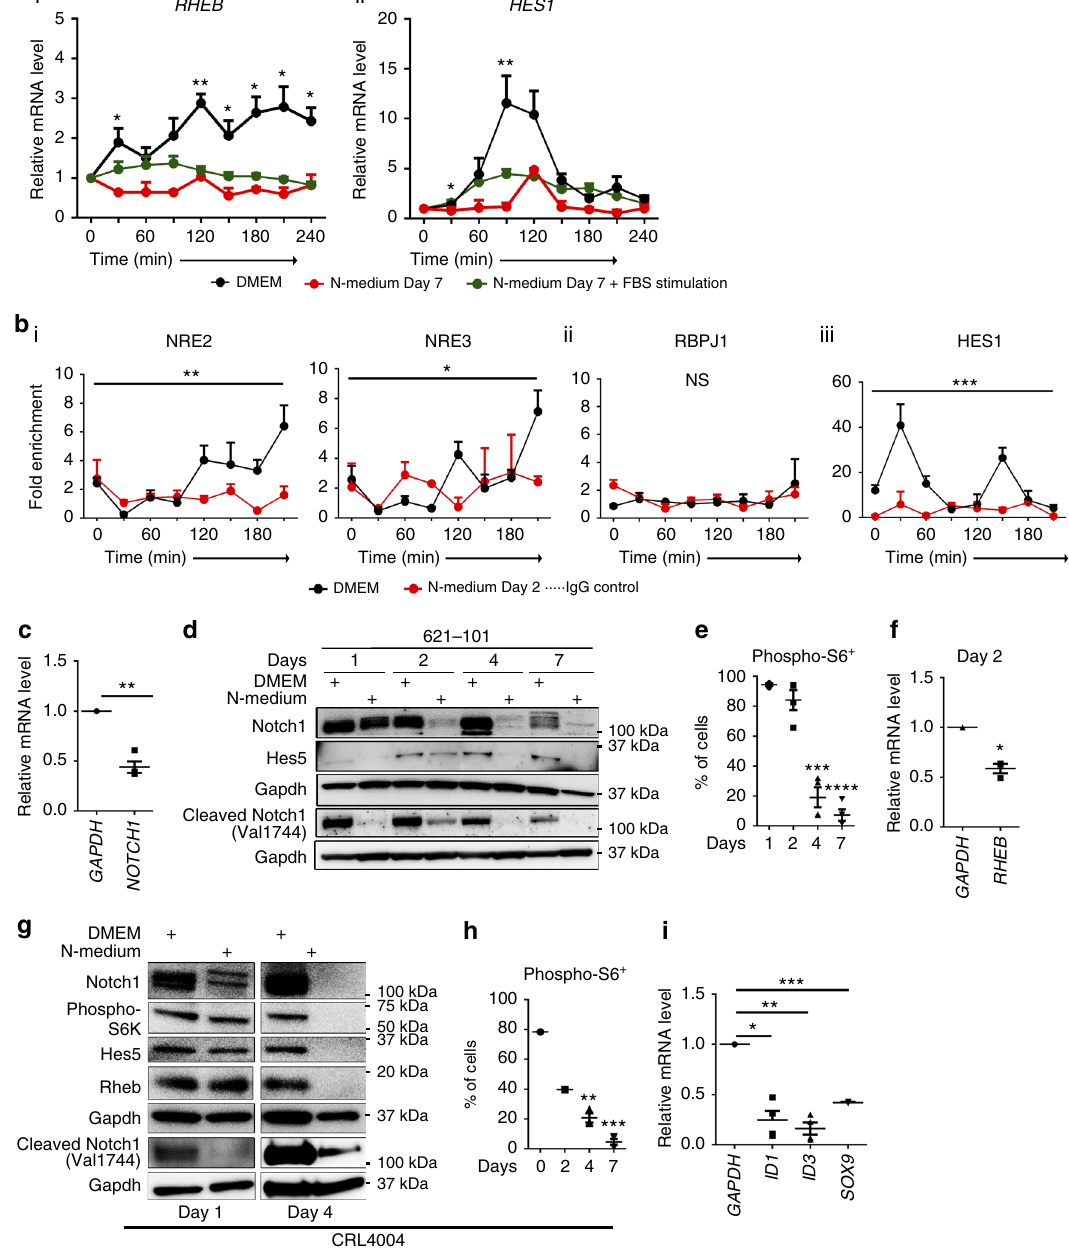
Fig. 4 Suppression of Rheb and Hes1 oscillation associates with neuronal differentiation of angiomyolipoma cells. a q(RT)-PCR of (i) RHEB and (ii) HES1 relative to GAPDH in synchronized 621 – 101 cells in N-medium (released with chicken embryo extract (red lines) or serum (green lines)) vs. DMEM (released with serum (black lines)) (data from DMEM are also used in Fig. 2a (i – ii)). The statistical signi fi cance of RHEB and HES1 expression in DMEM vs. N-medium was determined between corresponding time points. b Binding of Notch1 to the (i) NRE2, NRE3, and (ii) potential RBPJ1 site within the Rheb or (iii) Hes1 promoter, in synchronized 621 – 101 cells in N-medium vs. DMEM at day 2 by ChIP-qPCR (data from DMEM are also used in Fig. 2e (i – iv)). Asterisks represent the statistical signi fi cance of mean of time points in DMEM vs. N-medium, two-way ANOVA. c q(RT)-PCR of NOTCH1 in 621 – 101 cells in N-medium at day 2, relative to DMEM (control) after normalization to GAPDH . d Western blot of Notch1, Hes5, and cleaved Notch1 (Val1744) in 621 – 101 cells in N-medium vs. DMEM. e Percentage of 621 – 101 cells expressing phospho-S6 in N-medium by FACS. f q(RT)-PCR of RHEB in 621 – 101 cells in N-medium at day 2, relative to DMEM (control) after normalization to GAPDH . g Western blot of Notch1, phospho-S6K, Hes5, Rheb, and cleaved Notch1 (Val1744) in CRL4004 cells in N-medium vs. DMEM. h Percentage of CRL4004 cells expressing phospho-S6 grown in N-medium by FACS. i q(RT)-PCR of ID1 , ID3 , and SOX9 in 621 – 101 cells in N-medium at day 2, relative to DMEM (control) after normalization to GAPDH . Data represent means ± s.e.m. Error bars are de fi ned as means+ s.e.m. * P ≤ 0.05, ** P ≤ 0.01, *** P ≤ 0.001, **** P ≤ 0.0001, t -test ( a , c , e , f , h , i ), two-way ANOVA ( b ). Data are representative of two, n = 2 ( i for SOX9 ); three ( g ); three, n = 2 ( a , b (iii)); three, n = 3 ( h ); three, n = 4 ( b (i, ii)); four ( d ), four, n = 3 ( f ); four, n = 4 ( c , e , i for ID1 , ID3